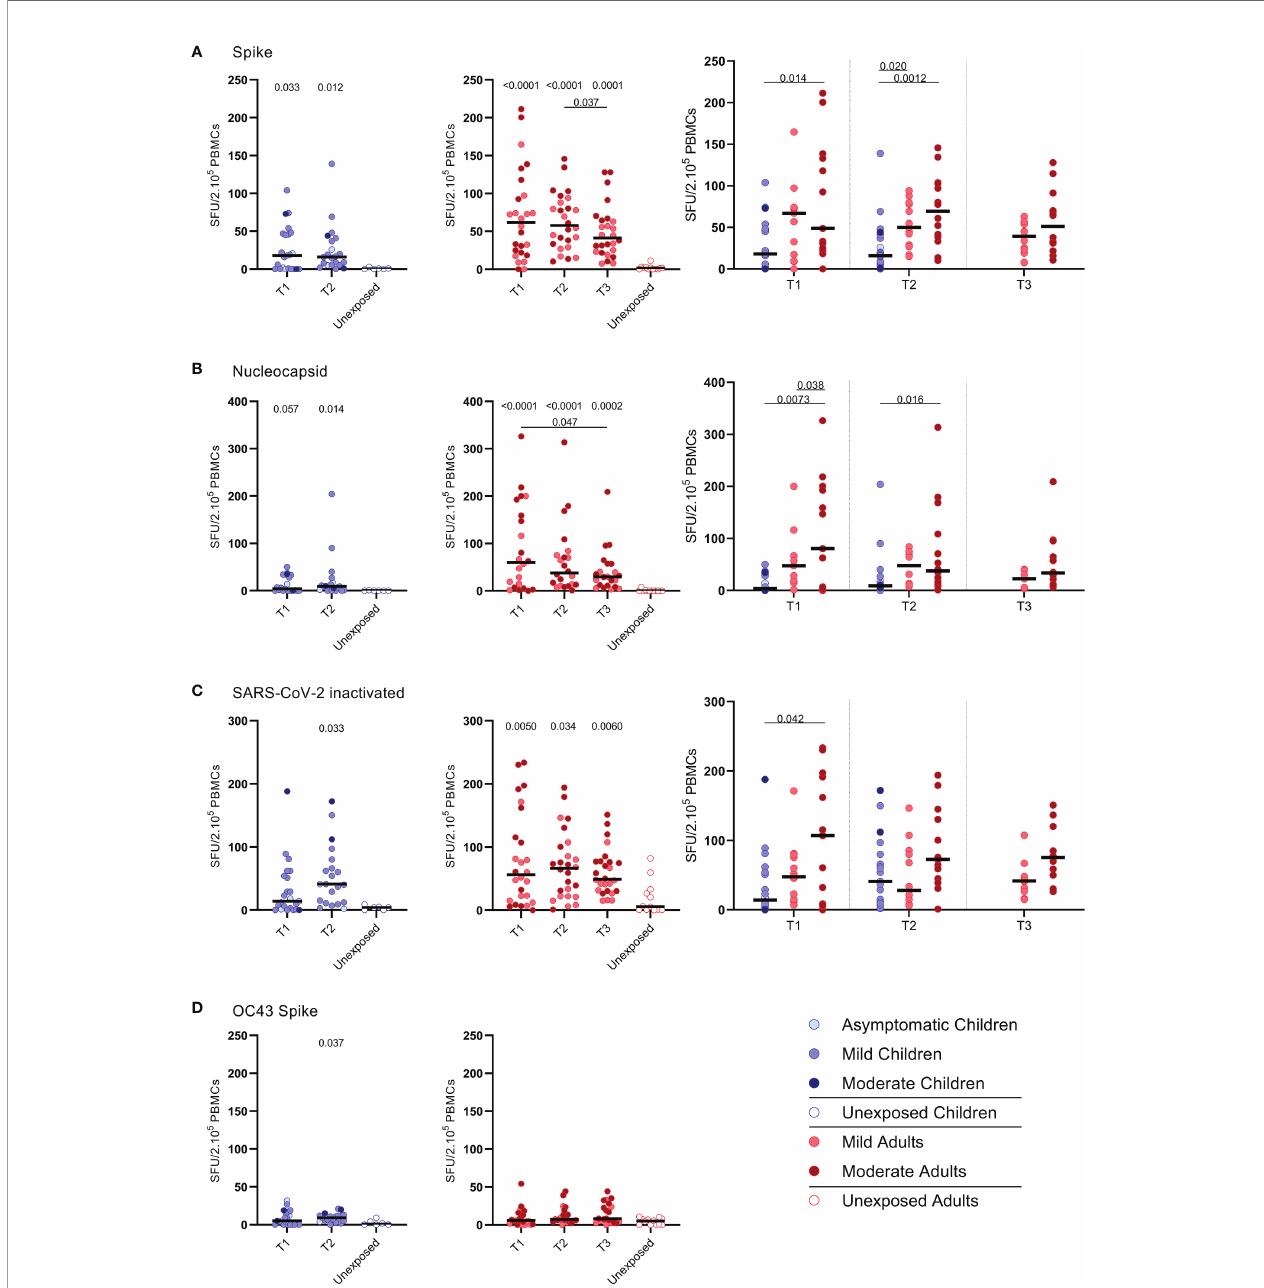
FIGURE 1 | SARS-CoV-2-speci fi c IFN- ɣ + T cell response in infected children and infected adults (mild and moderate cases) versus unexposed healthy controls over time after infection. Dot plots summarizing the frequencies of IFN- g -producing cells responding to SARS-CoV-2 and HCoV-OC43 antigens for (A – D) children (left panel, blue), adults (middle panel, red), and children versus mild and moderate adult cases separately (right panel), over time after infection, and compared to unexposed adults/children (ELISPOT assay). Frequencies of IFN- g -producing cells responding to (A) set of overlapping peptides of SARS-CoV-2 spike protein, (B) set of overlapping peptides of SARS-CoV-2 nucleocapsid protein, (C) inactivated SARS-CoV-2, and (D) set of overlapping peptides of HCoV-OC43 spike protein. Each dot represents one subject. Bars indicate the median of spot-forming units per 200,000 PBMCs. SFU, spot-forming unit. (A – D) P values related to comparisons with the unexposed controls are listed at the top of the graph, above the corresponding group for comparison. For unpaired comparisons, Mann- Whitney U test (two-group comparisons) (mild adults versus moderate adults) or Kruskal-Wallis rank-sum test with Dunn ’ s post hoc test for multiple comparisons were used (children versus mild adults versus moderate adults; unexposed versus infected children or adults at T1 versus T2 versus T3). Differences between paired data were compared using the Wilcoxon signed-rank test (for comparison of two paired groups) (infected children at T1 versus T2) or the Friedman test with Dunn ’ s multiple comparison tests (infected adults at T1 versus T2 versus T3). Statistically signi fi cant comparisons are indicated, with P values < 0.05 considered signi fi cant. T1, fi rst timepoint of sampling for adults median 12.5 days and children median 8 days post-symptom onset; T2, 10-14 days after T1; T3, 4-6 weeks after